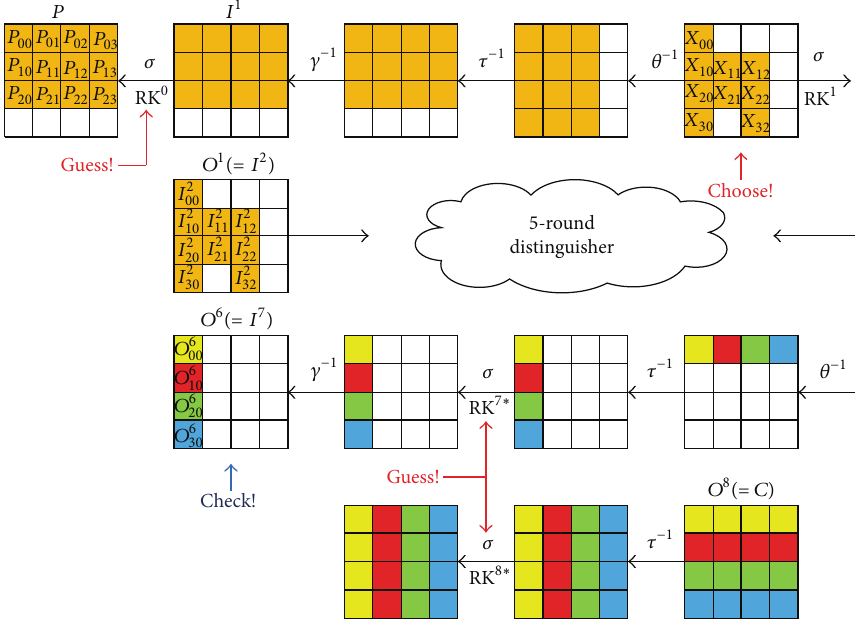
Figure 7: The attack procedure on